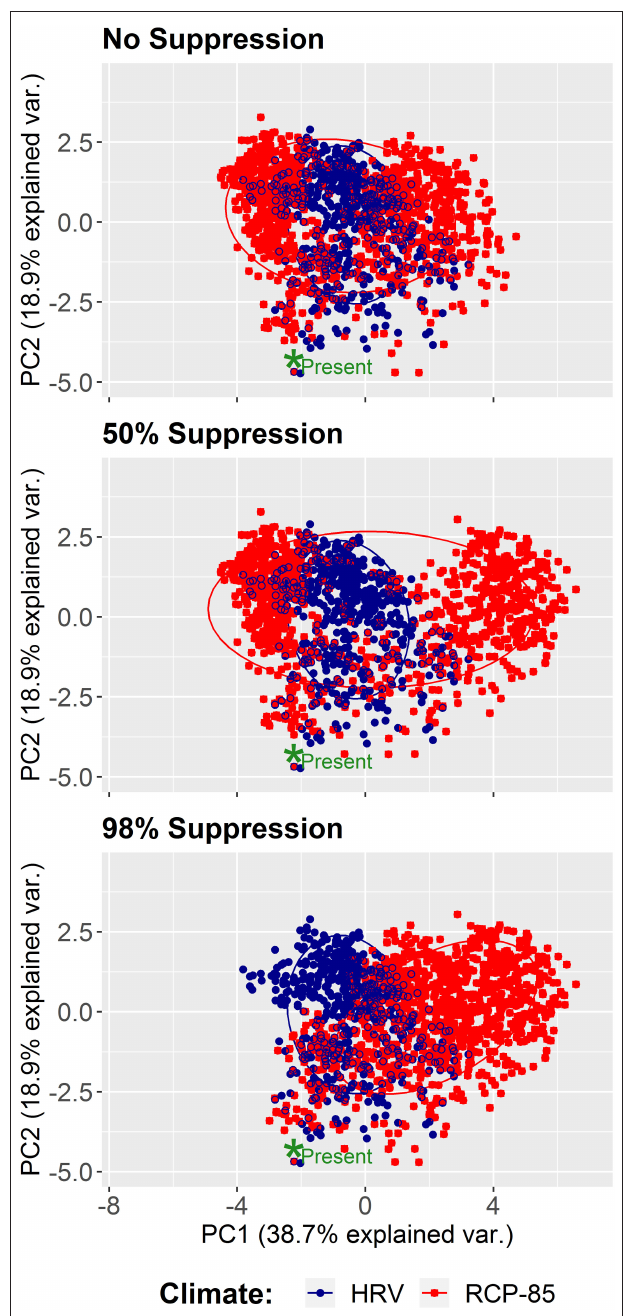
FIGURE 3 | Principal components analysis (PCA) of multivariate model responses for the East Fork of the Bitterroot River watershed, Montana, USA, for an historical time period (HRV, blue dots) and three future scenarios that combined future climate (CRM-C5 RCP8.5) with three levels of fire suppression (0%, 50%, 98%, red dots). Red or blue circles contain 68% of the variation in the spread of the points for the three scenarios; the green asterisk represents the present state of the landscape in multivariate space. Overlapping HRV and FRV zones suggest less departure from historical conditions and greater landscape resilience; increasing distance between HRV and FRV occurred with higher fire suppression levels, suggesting that suppression may not be an effective management strategy under changing climates. Adapted from Keane et al.